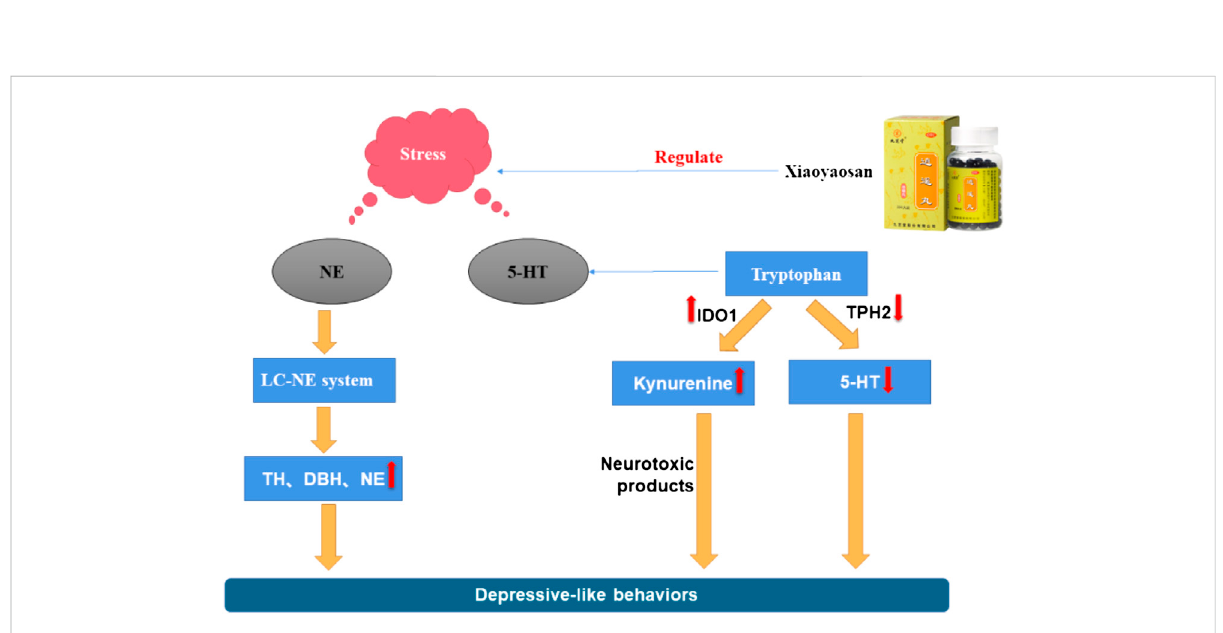
FIGURE 2 Mechanism of the stress-induced changes in NE and 5-HT and the regulating effect of Xiaoyaosan.